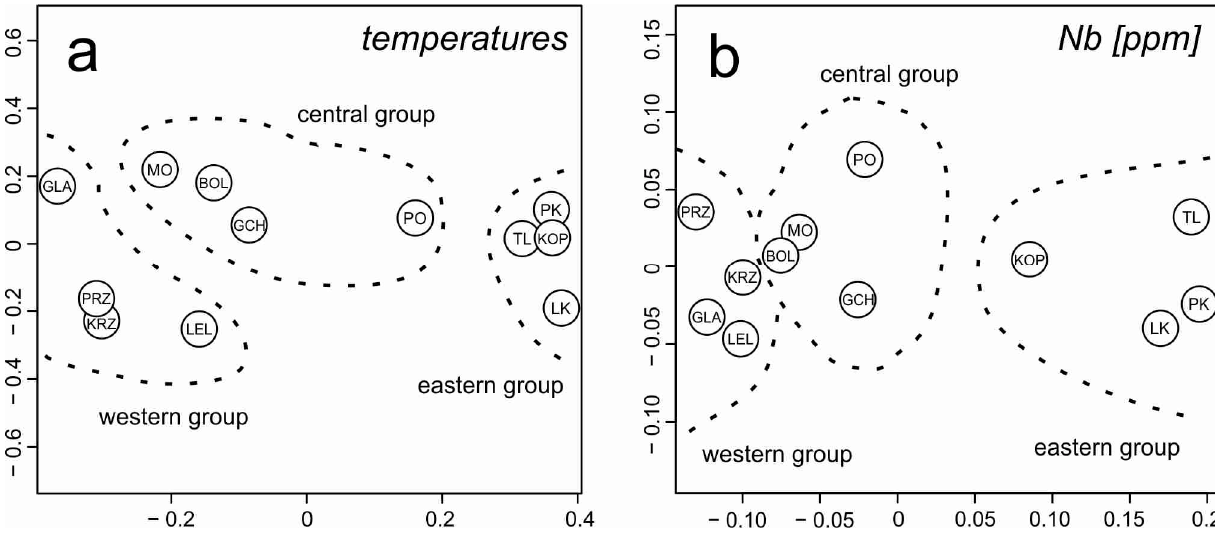
Figure 9. Nonmetric multidimensional scaling (MDS) maps of ( a ) calculated crystallization temperature of detrital rutile grains using the Watson et al. formula [32] detailed explanation in the text; ( b ) Nb (ppm) concentrations in rutile.